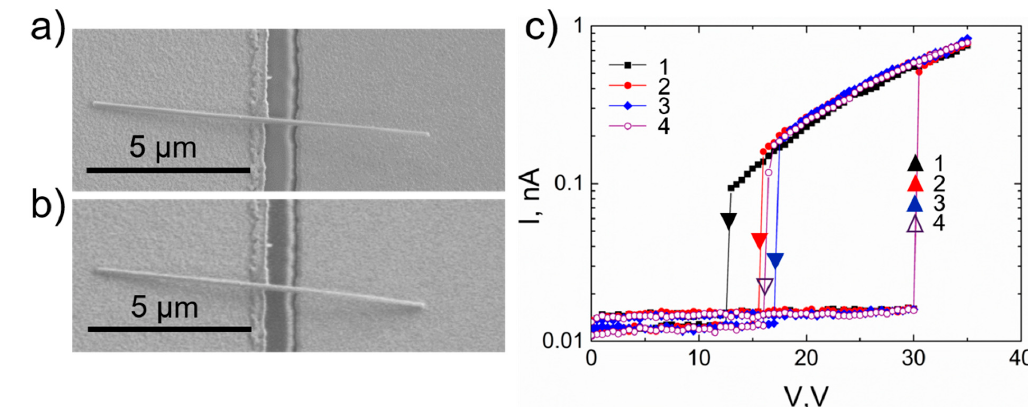
Figure 6. CuO nanowire-based NEM switch in a single-clamped configuration. SEM image of the NEM switch in ( a ) OFF state, ( b ) ON state; ( c ) Switch I–V cycling showing sharp transition to ON (at 30 V) and OFF (at 13–17 V) states, four switching cycles are shown. Upwards arrows mark transition to ON state, downwards arrows–transition to OFF state. Dimensions for this device: suspended length L 0 = 3 μ m, diameter d = 80 nm, and the initial distance between nanowire and electrode z 0 = 190 nm.